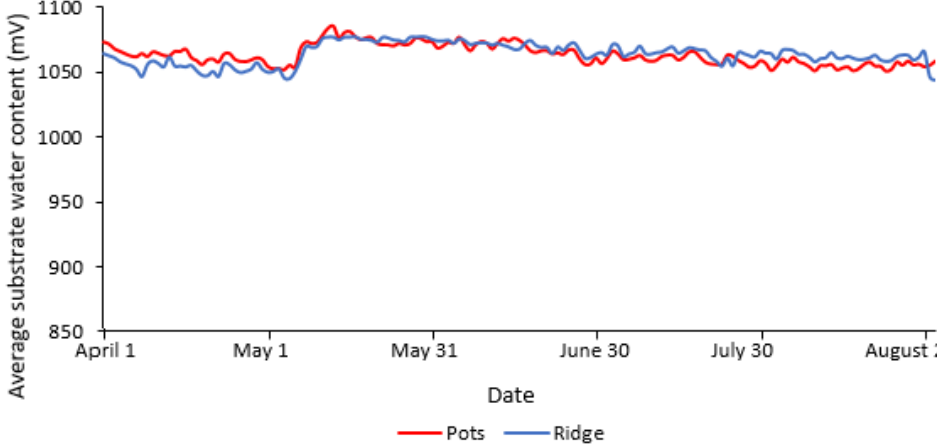
Figure 1. Substrate water content (mV) for the pots and ridge from 1 April 2020 to 31 August 2020.